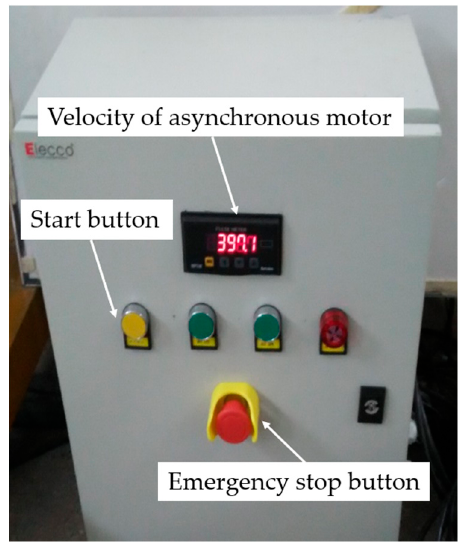
Figure 15. Control cabinet and display.